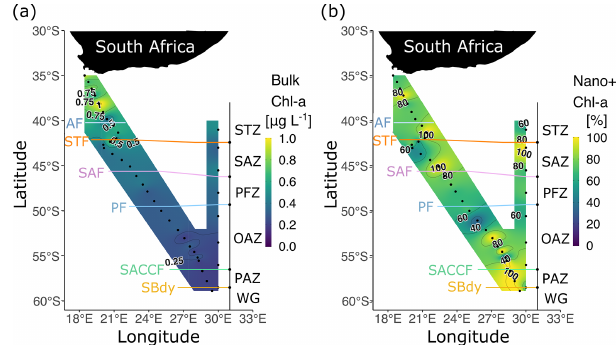
Figure 4. Bulk δ 15 N-PON at the surface for leg S in winter 2017. The two stations nearest South Africa at which biomass concentra- tions were extremely high have been excluded. Abbreviations are as in Fig. 1. Figure produced using the package ggplot2 (Wickham,